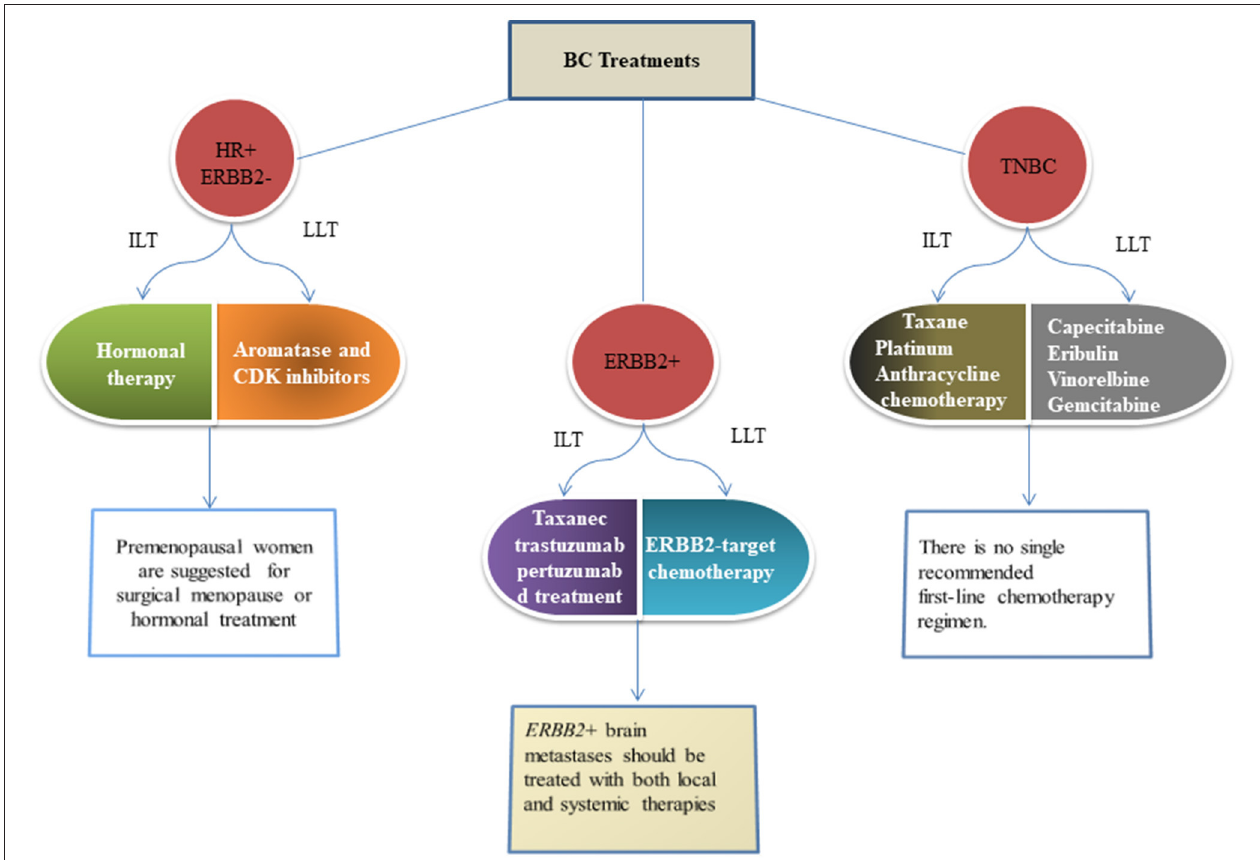
FIGURE 3 | Figures give the recommended standard approaches to therapy of metastatic BC as per the guideline of the American Cancer Society. These recommendations are adopted in ( 108) and are given as per the guidelines of the National Comprehensives Cancer Network (109). HR, Hormonal receptor; ERBB2, Epidermal growth factor-2; TNBC, Triple negative breast cancer; ILT, Initial line of therapy; LLT, Later line of